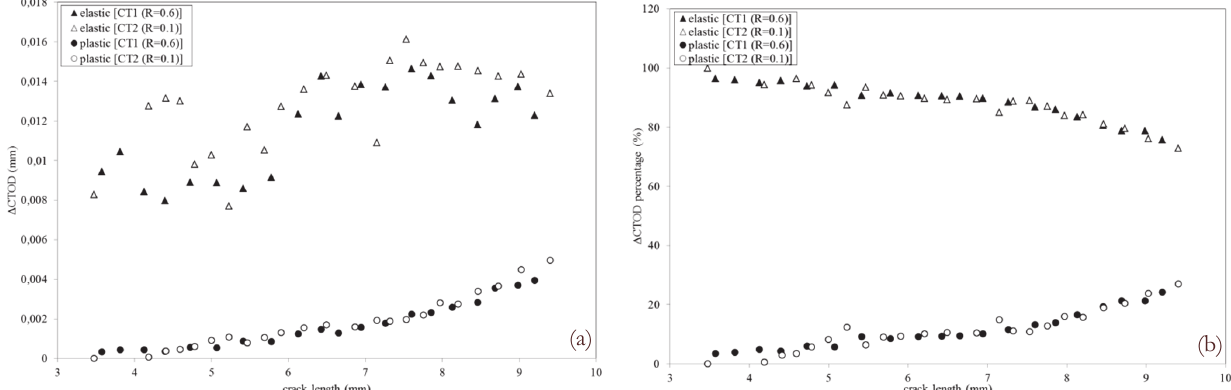
Figure 8: (a) Elastic and plastic CTOD ranges as a function of the crack length for both tests. (b) Percentage of the elastic and plastic CTOD ranges along the crack length for both